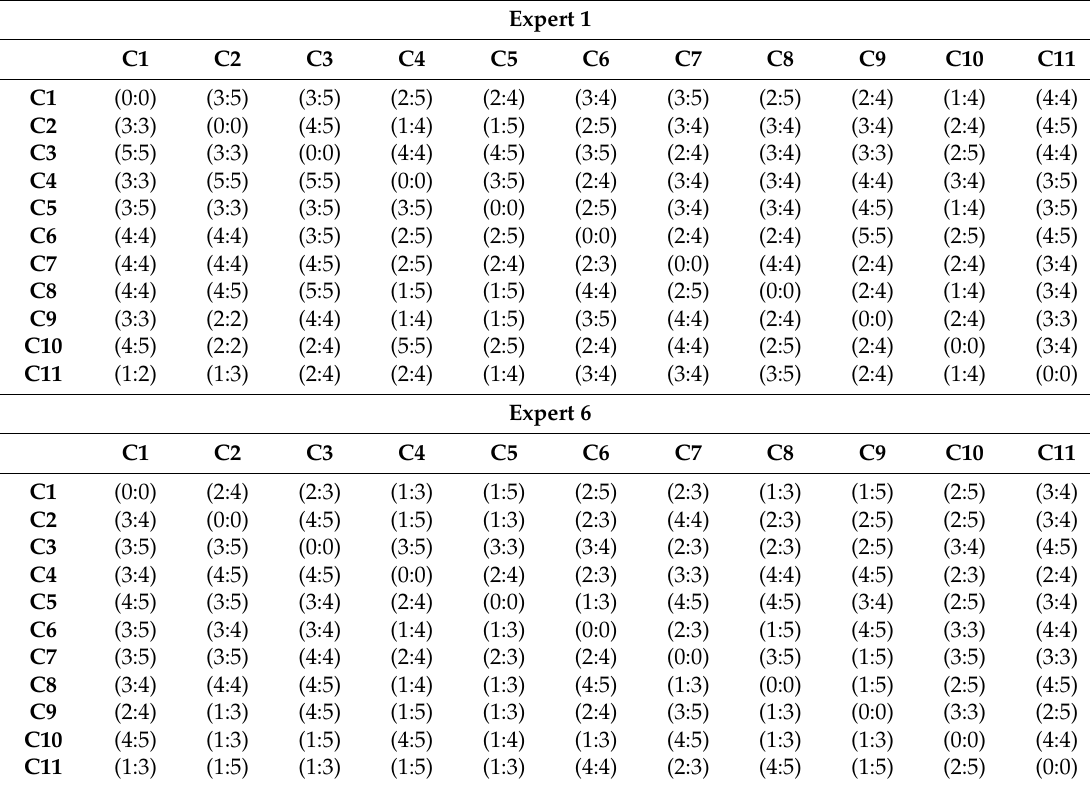
Table 3. Expert comparison matrix in the pairwise conditioning factors. Expert